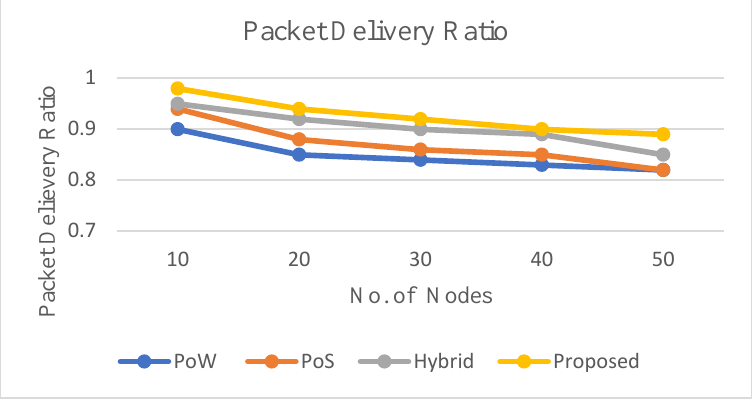
Figure 7. Packet Delivery Ratio.